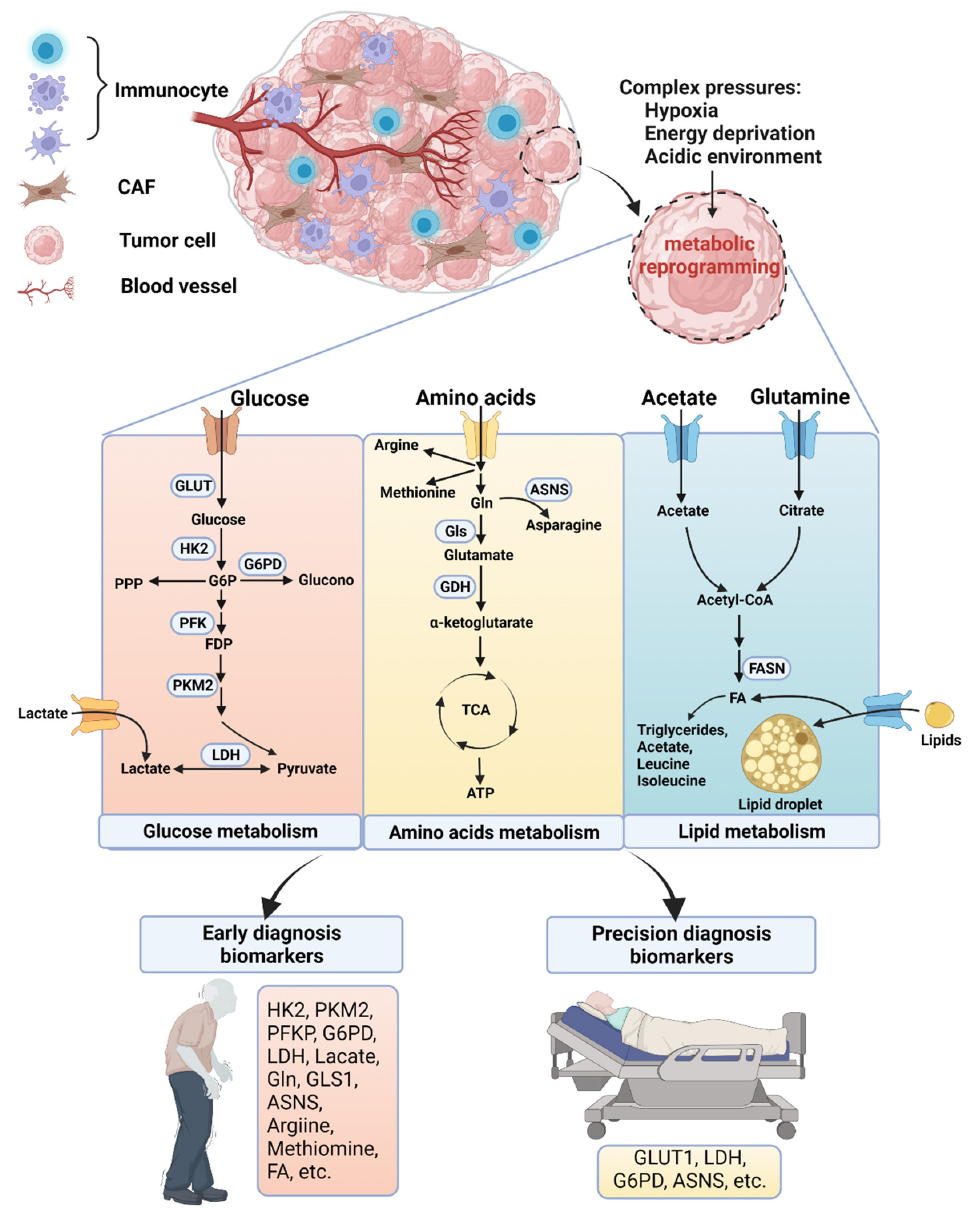
Figure 1. Screening altered cellular metabolism to diagnose OSCC. OSCC undergoes metabolic reprogramming of glucose, lipids and amino acids in response to complex pressures. Identifying metabolism-associated biomarkers facilitates early and precision diagnosis. CAF, cancer-associated fibroblast; LDH, lactate dehydrogenase; Gln, glutamine; ASNS, asparagine synthetase; Gls, glutaminase; GDH, glutamate dehydrogenase; TCA, tricarboxylic acid; ATP, adenosine triphosphate; FA, fatty acid; FASN, fatty acid synthase. Figure created with biorender.com.